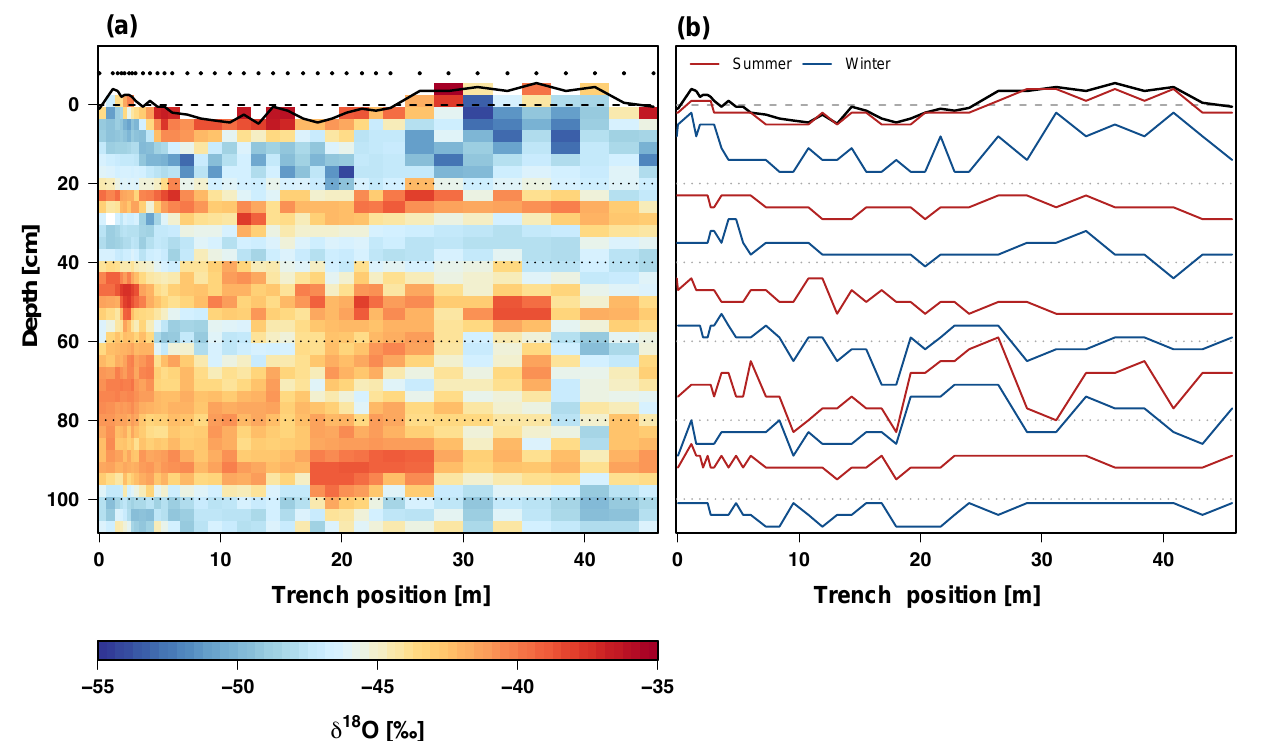
Figure 2. (a) The two-dimensional δ 18 O data set of trench T1 displayed on absolute coordinates. The solid black line shows the surface height profile, the long-dashed black line the mean surface height. Sampling positions are marked by the black dots above. White gaps indicate missing data. (b) The stratigraphy of trench T1 expressed as the seasonal layer profiles tracking the local δ 18 O extrema as explained in the